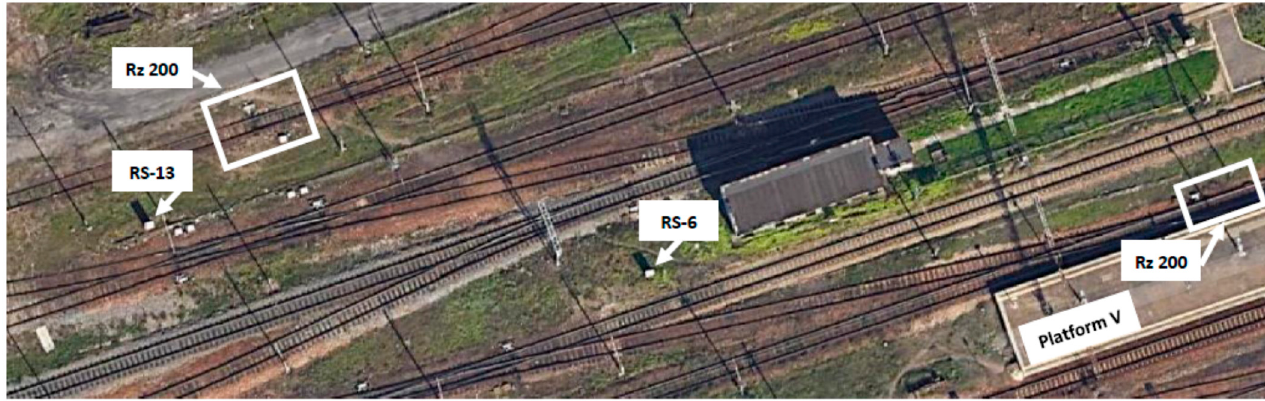
Figure 7. Satellite photo of a part of the track layout of the Warszawa Zachodnia station with marked turnouts and the apparatus and supply cabinets assigned to them (source: authors).